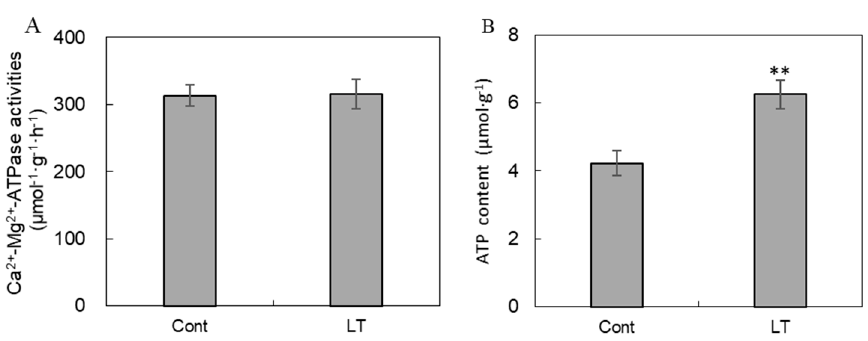
Figure 7. ATPase enzyme activities and ATP content under low temperature and control conditions in wucai leaves. The activity of Ca 2+ /Mg 2+ -ATPase ( A ) and ATP content ( B ) are shown. * represents significant at p < 0.05, ** represents significant at p < 0.01.